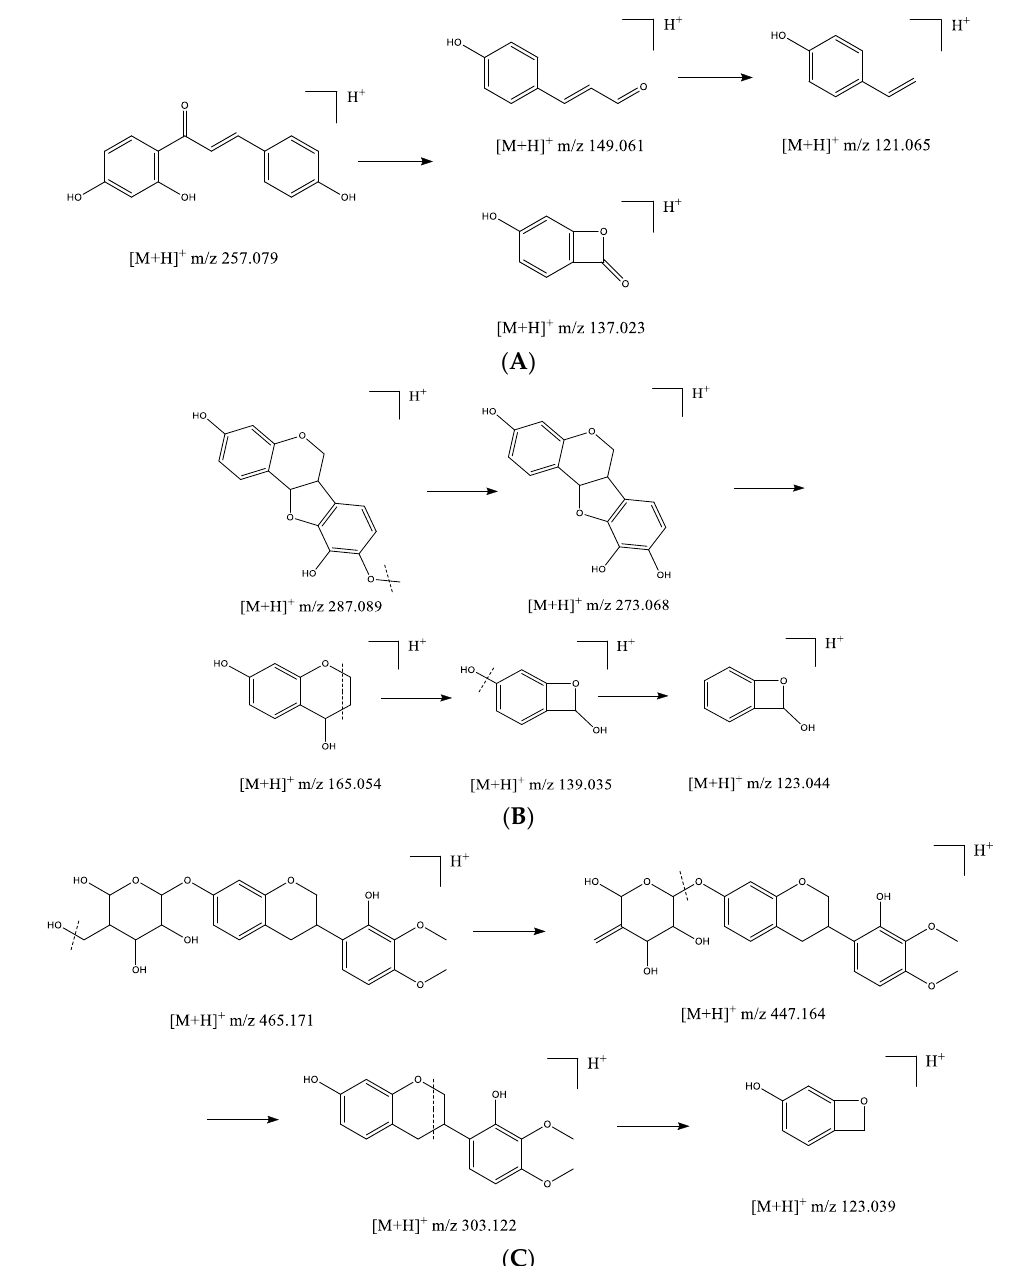
Figure 2. The putative fragmentation pathways of isoliquiritigenin ( A ), vesticarpan ( B ), and isomucronulatol 7- O -glucoside ( C ). Table 1. The identified flavonoids compounds of Astragalus based on the UHPLC-ESI-MS/MS method.